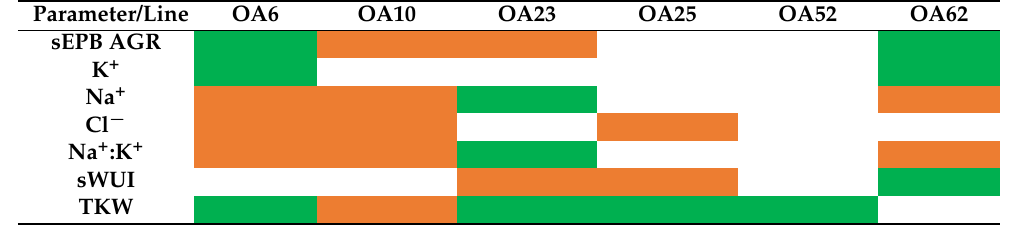
Table 2. The overall pattern of parameters measured. Green, overall higher values than BARI Gom-25; orange, overall lower values than BARI